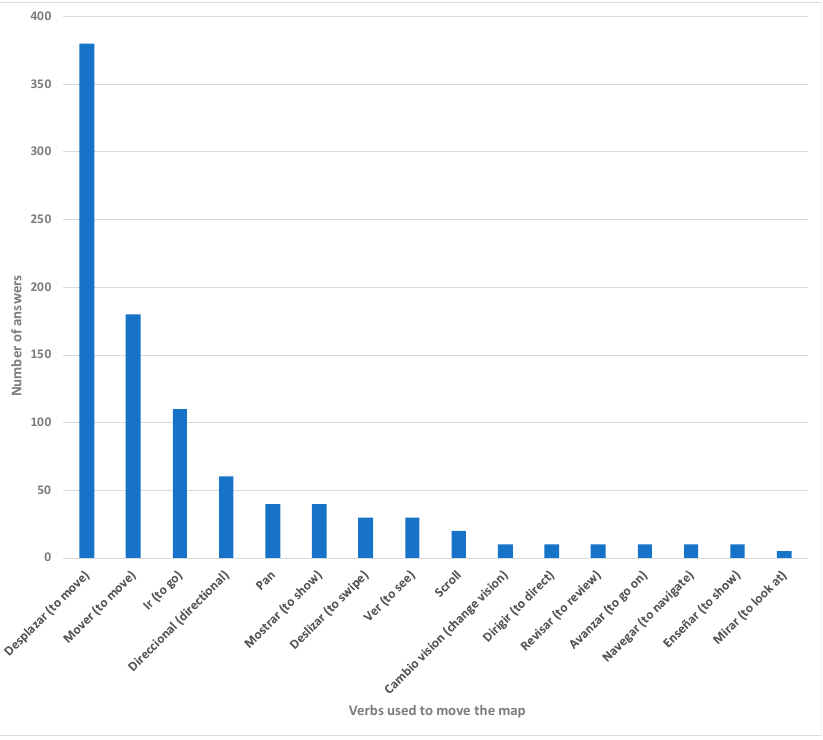
Figure 6. Requests to change layer functionality. All correlations between age, gender, level of education, and level of familiarity with virtual assistants or GISs and differences in vocabularies were analyzed. The results were largely consistent within each category. However, the untrained, elderly, and children were too poorly represented to determine correlations for these user profiles with any certainty. Additional dedicated studies with more users in these specific groups are needed to observe their specific characteristics. The most important result of the survey was the identification of a corpus of vocab- ulary used to interact by voice with a map. 01020 3040 50 60 N u m b e r o f a n s w e r s Verbs used to change layer